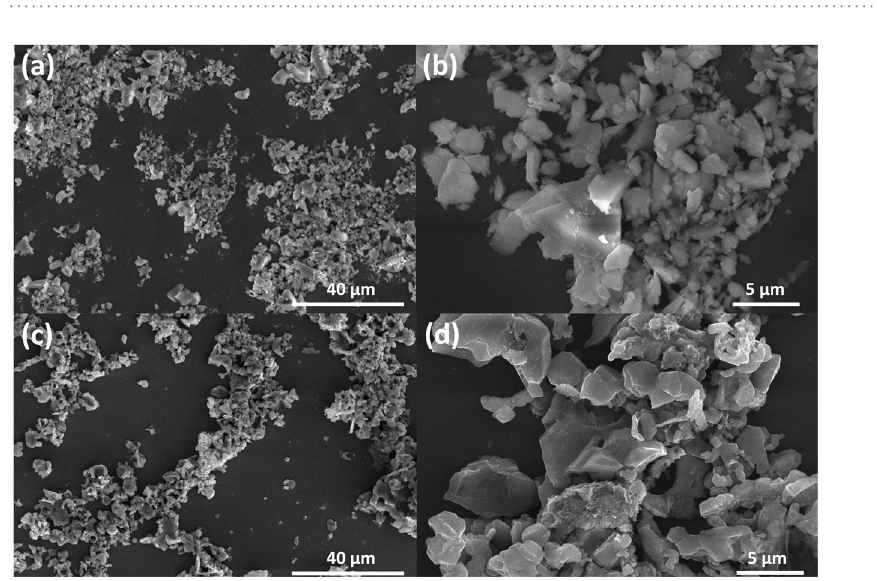
Figure 3. ( a ) Low magnification and ( b ) High magnification SEM images of milled glass powder. ( c ) Low magnification and ( d ) High magnification SEM images of gSi after reduction and